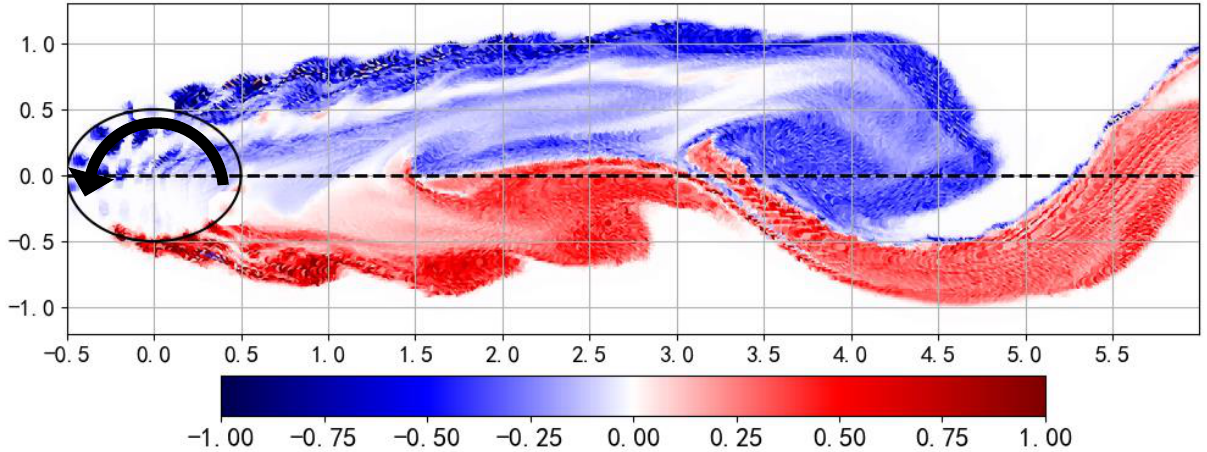
Figure 9. The vorticity field at the near wake. The X-axis is the streamwise position which is normalized by the turbine diameter ( X/D ). The Y-axis is the lateral position which is normalized by the turbine diameter ( Y/D ). The color bar is the nondimensional vorticity which is normalized by the maximum vorticity in the field ( ω/ω max ).